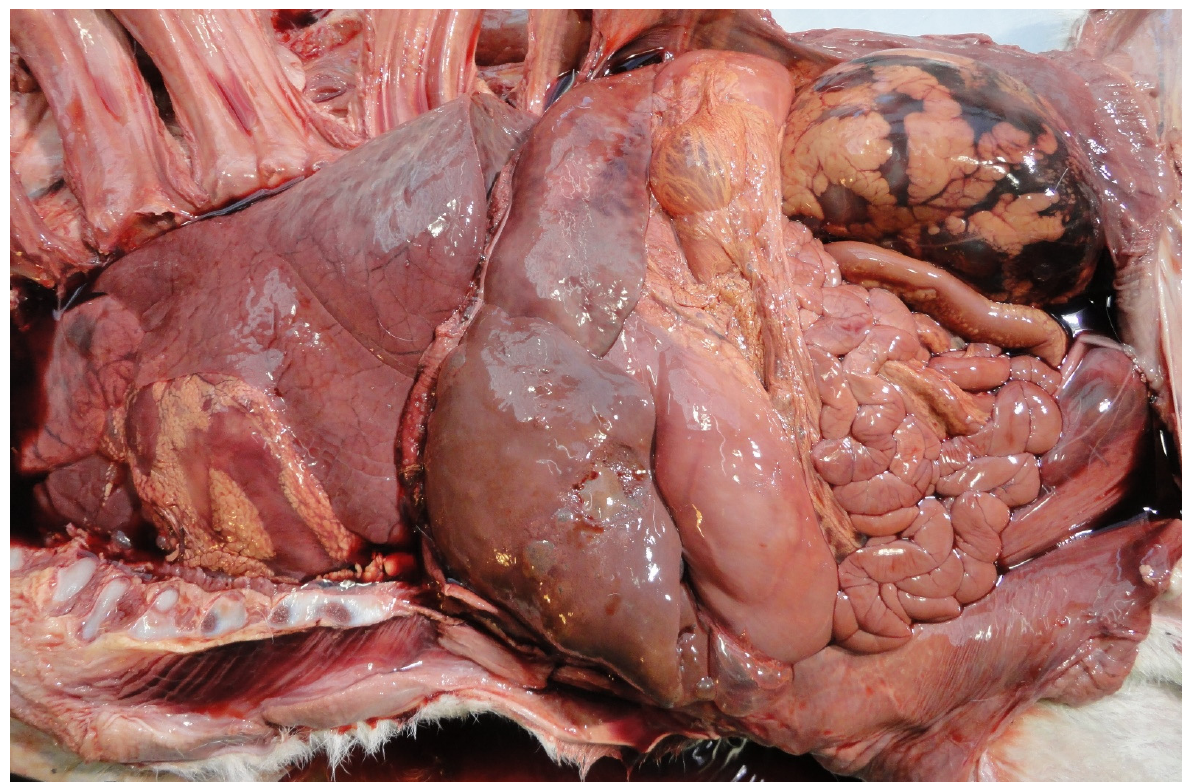
Figure 3. Autolysed foetus infected with Salmonella Dublin.